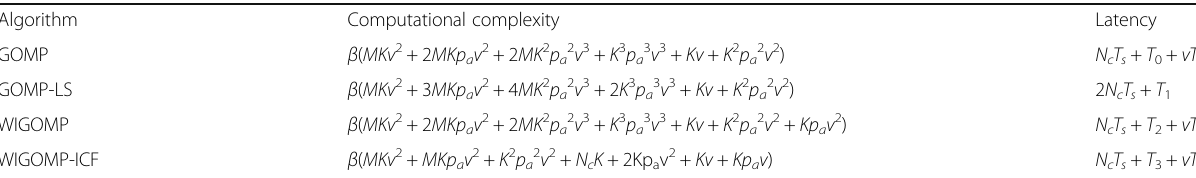
Table 1 Comparison of computational complexity and latency